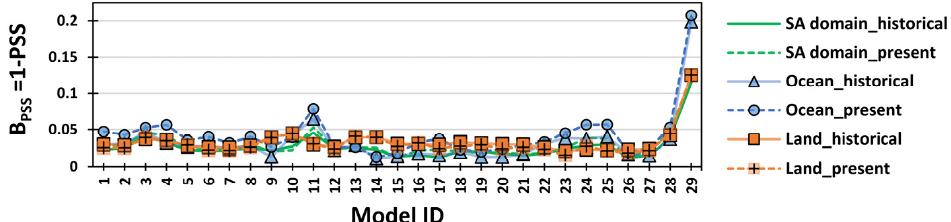
Figure 2. Assessment criteria statistic (ASC) of CMIP5 GCMs summary in reproducing frequency distribution of daily mean wind speed over South Asian (SA) domain for historical period (1979–2005) (green solid line), over SA domain for present period (2006–2019) (green dashed line), over ocean for historical period (blue solid line with triangle markers), over ocean for present period (blue dashed line with circle markers), over land for the historical period (orange solid line with plus sign markers), and over land for present period (orange dash line with square markers); ASC (bias in Perkins Skill Score ( B (cid:2900)(cid:2903)(cid:2903) )) on y ‐ axis and Model ID on x ‐ axis.